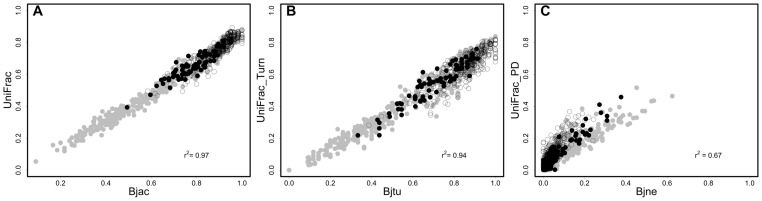
Relationship among Compositional Beta Diversity (CBD, A  =  βjac, B  =  βjtu and C  =  βjne) and Phylogenetic Beta Diversity (PBD, A  =  UniFracTotal, B  =  UniFracTurn and C  =  UniFracPD) components.Symbol colors indicate the region where the sites occur in the Brazilian Atlantic Forest. Black circles indicate dissimilarity between sites within stable region (Quaternary Climatic Stability). Gray circles indicate dissimilarity between sites within unstable region (Quaternary Climatic Oscillations). White circles indicate dissimilarity between unstable and stable sites (different regions).